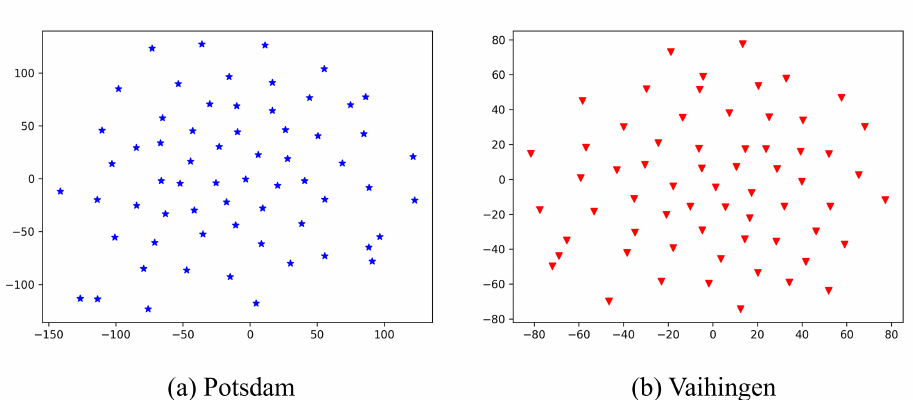
Figure 7. The T-SNE results of the memory prior. Different memory tends to encode different features due to the scattered distribution of the visualization